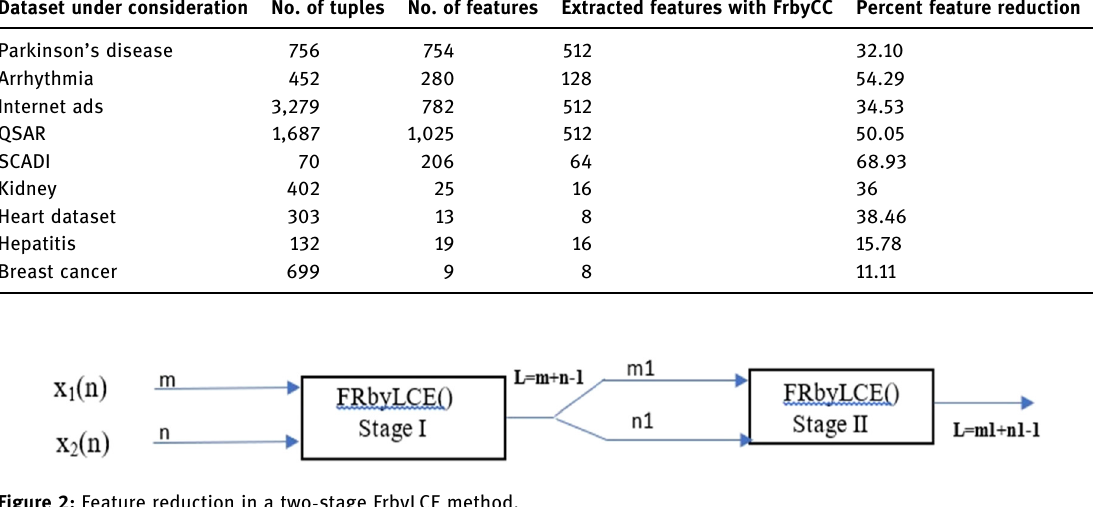
Figure 2: Feature reduction in a two - stage FrbyLCE